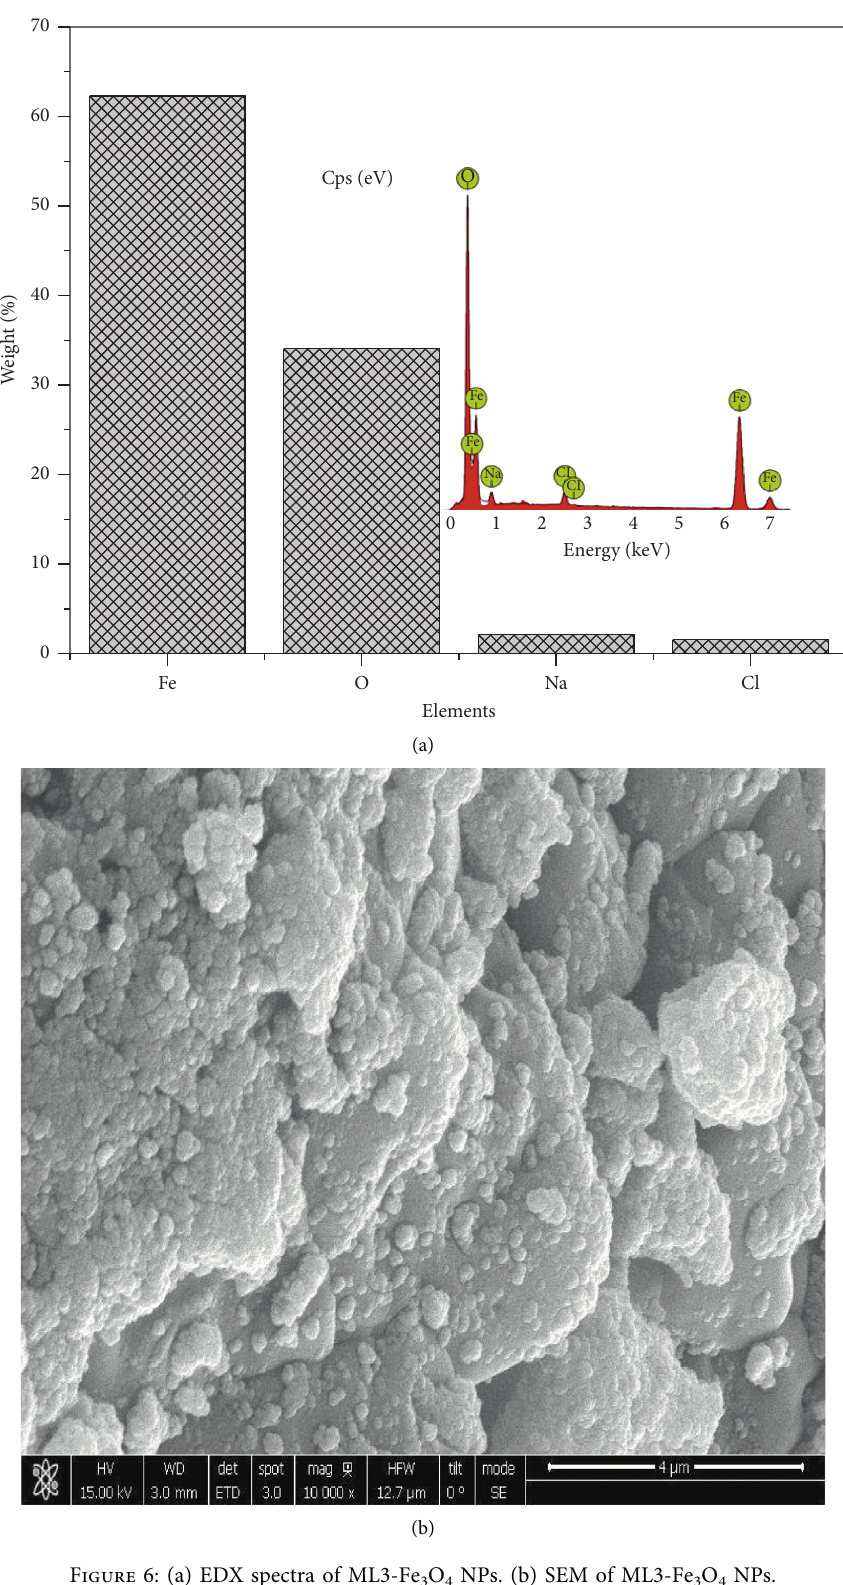
Figure 6: (a) EDX spectra of ML3-Fe 3 O 4 NPs. (b) SEM of ML3-Fe 3 O 4